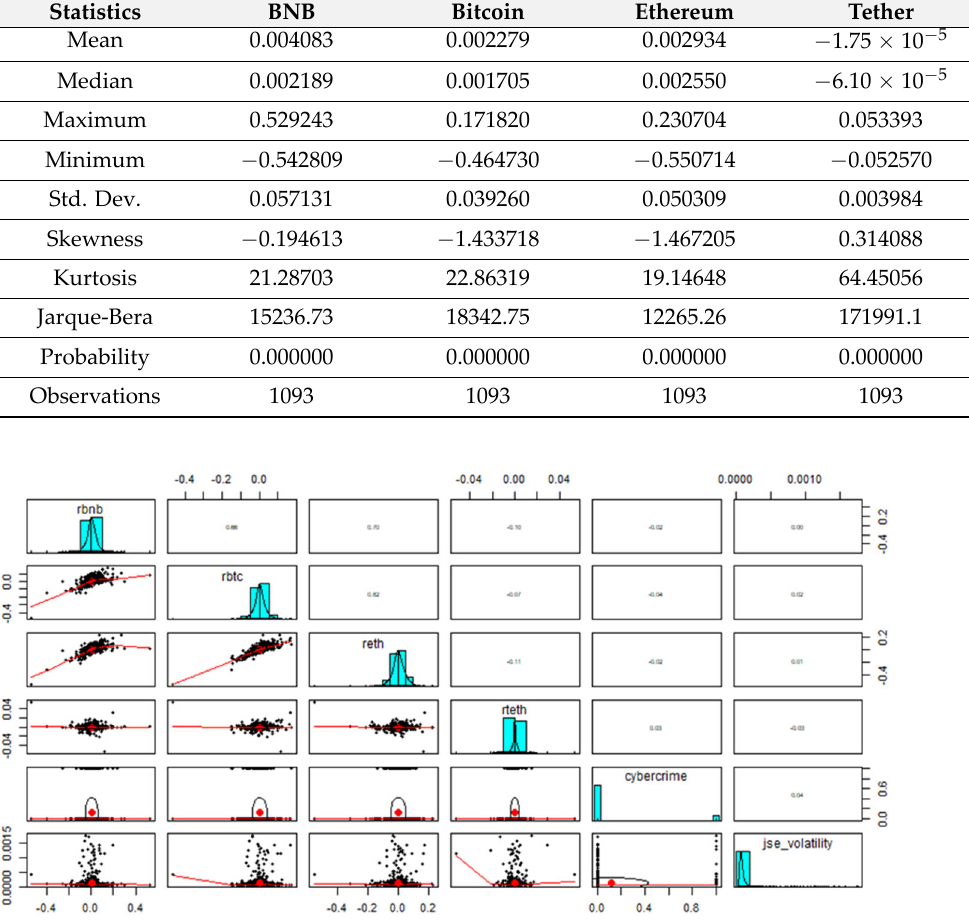
Figure 1. Correlation chart of cryptocurrency returns with cybercrime and stock market volatility.